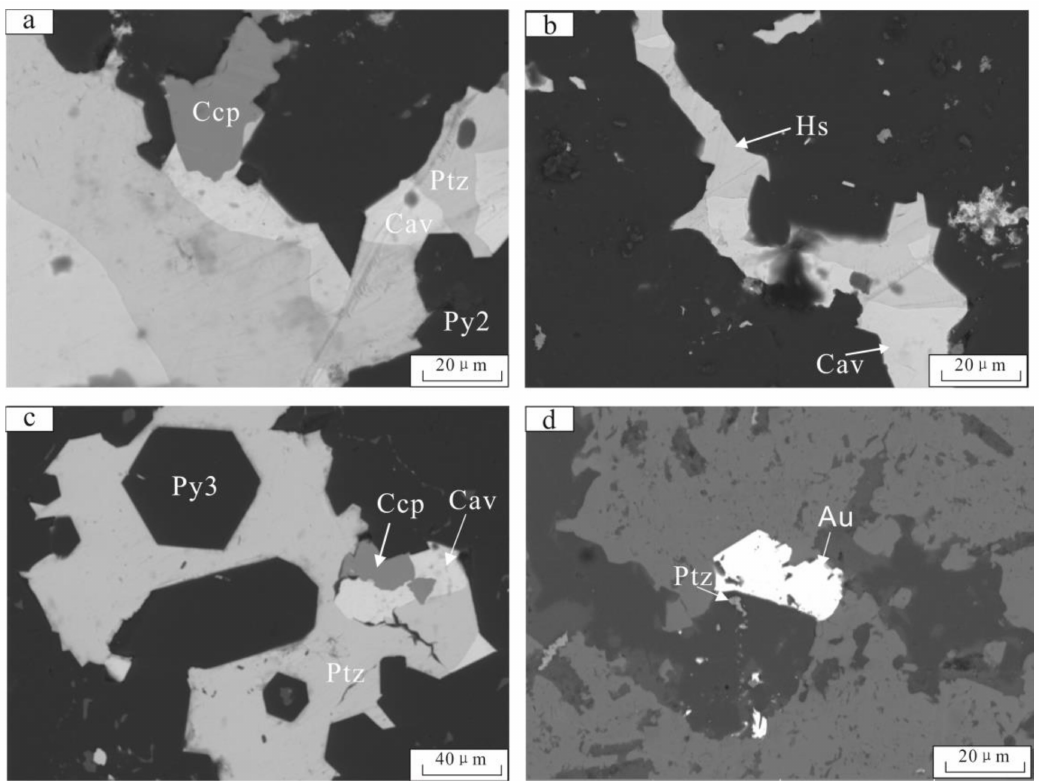
Figure 10. Back-scattered electron images of telluride assemblages. ( a ) In the microfracture of Py2, chalcopyrite grew with calaverite and petzite, and calaverite was generated earlier than petzite. ( b ) Hessite crosscut calaverite. ( c ) Chalcopyrite is coexisting with tellurides. Tellurides formation was later than Py3. ( d ) Native Au grew with petzite. Only simple telluride assemblages contain petzite, calaverite and hessite. As the only sulfide, chalcopyrite grows with telluride assemblages. Au has been recognized with telluride assemblages. Ptz: petzite; Cav: calaverite; Hs: